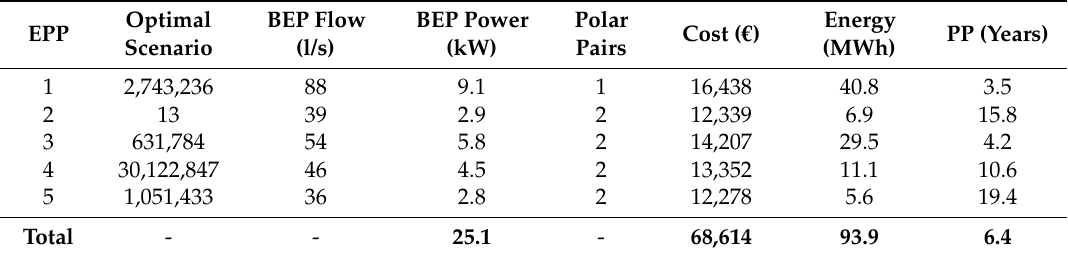
Table 3. Summary of the results obtained for each EPP and for the set, showing the optimal scenario, BEP flow, BEP power of the optimal scenario, number of polar pairs of the electromechanical device, total installation costs, energy recovered in the optimal scenario and its